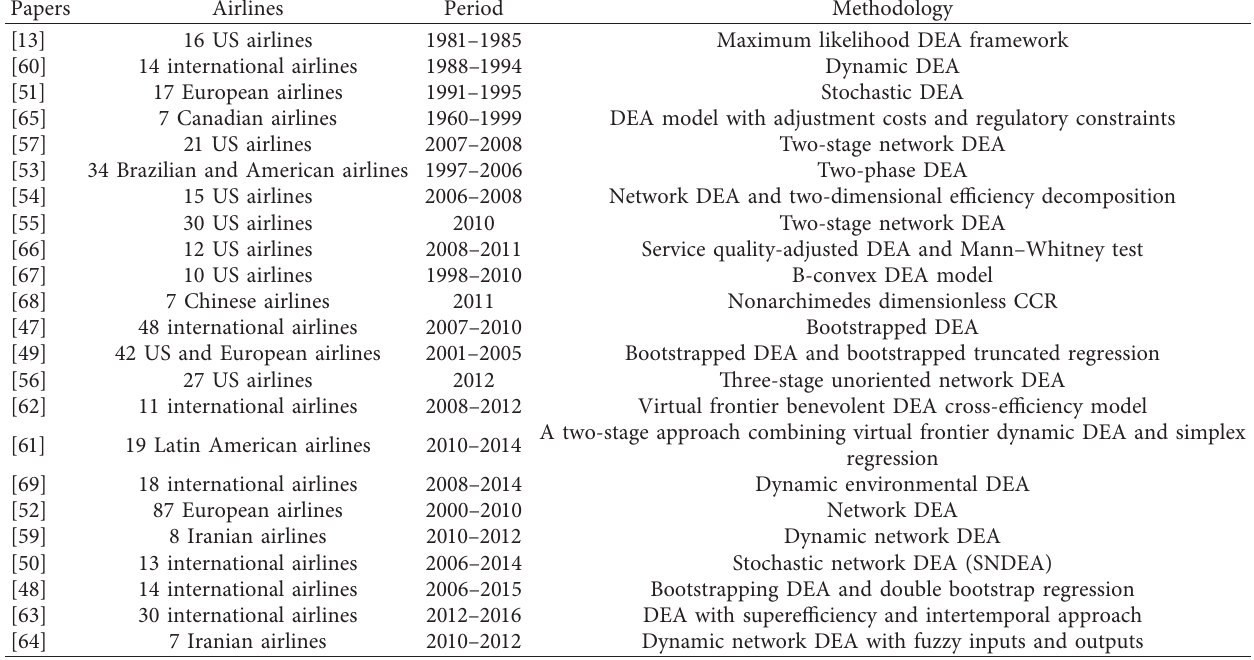
Table 3: Application of extended DEA in airline